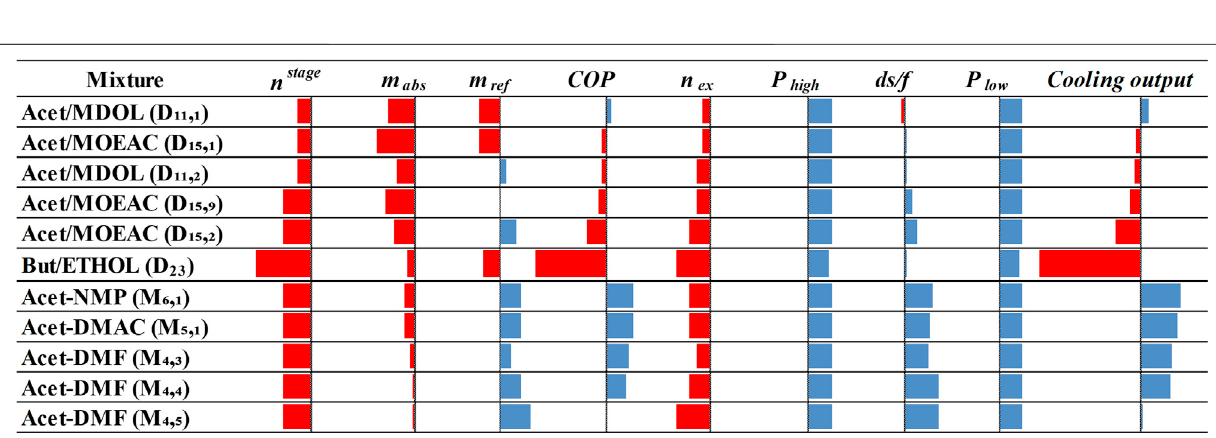
Frontiers in Chemical Engineering |